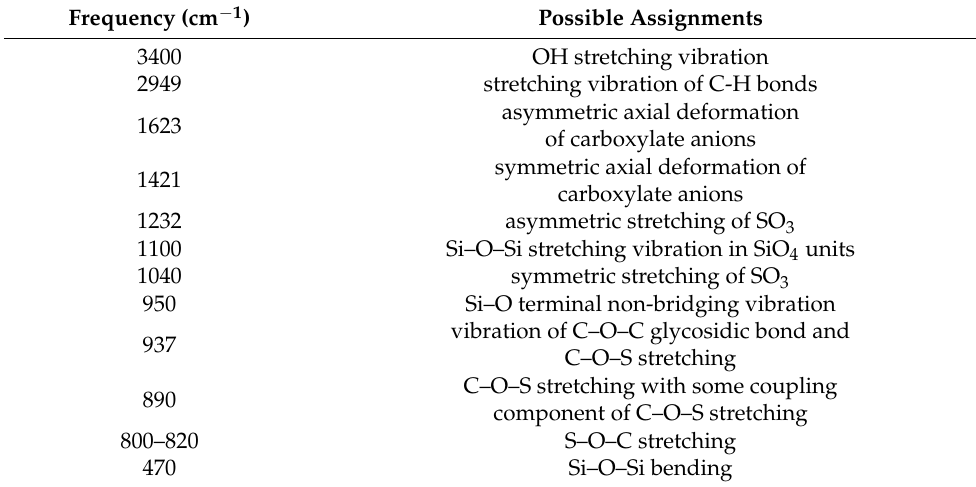
Figure 6. FTIR spectra of both bare heparin ( A ), silica ( B ), SiO 2 − Hep_1 ( C ), SiO 2 − Hep_3 ( D ), and SiO 2 − Hep_5 ( E ) hybrid nanoparticles. Table 4. Main absorption bands and assignments in the FTIR spectra.